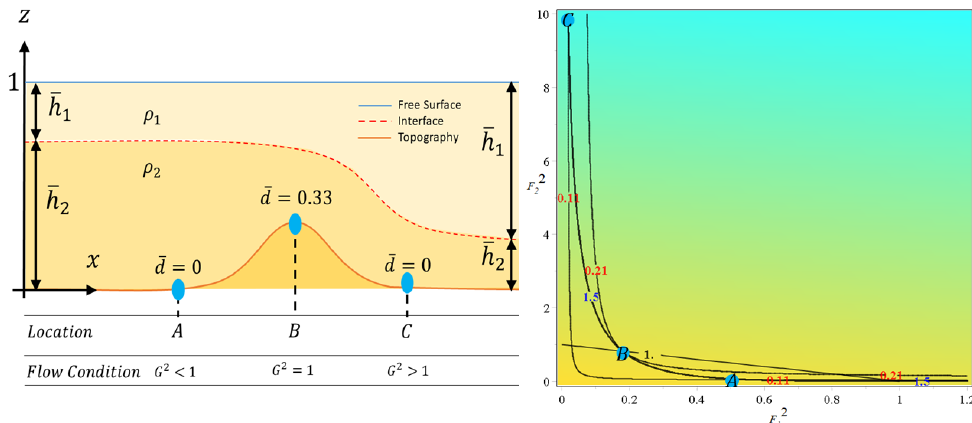
Figure 7. ( Left ) Side view of the steady interface of the smooth transcritical flow due to a bottom sill (not to scale). ( Right ) The Froude number planes with several contours of the rigid-lid and Bernoulli are plotted in red and blue labels, respectively, whereas the straight line represents the criticality condition (9). The Bernoulli contour, shown as a thick solid curve A − B − C , depicts the steady interface of the smooth transcritical